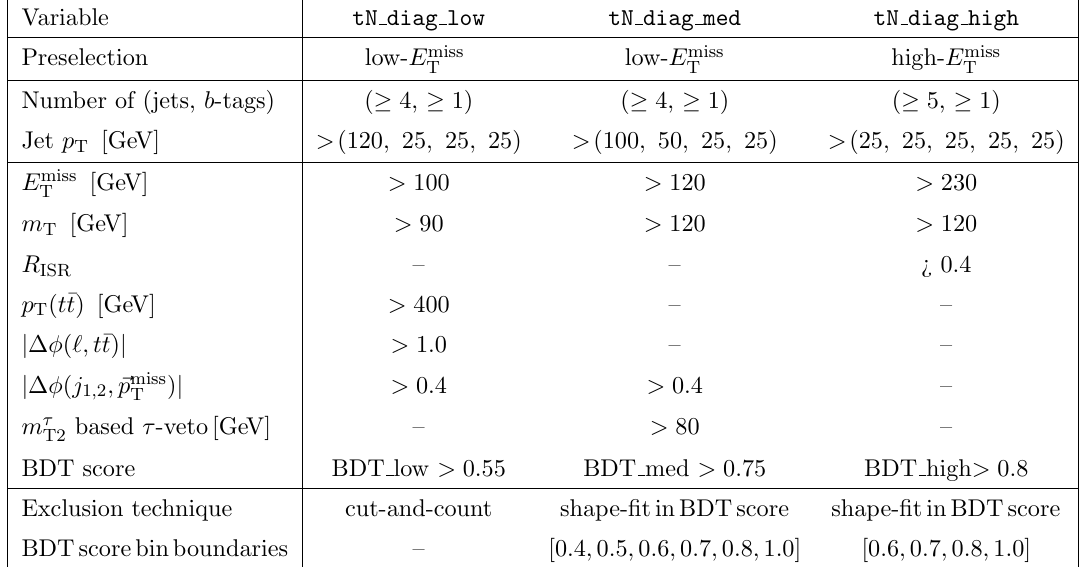
Table 7 . Overview of the signal selections using BDTs to target compressed ~ t List values are provided in between parentheses and square brackets denote